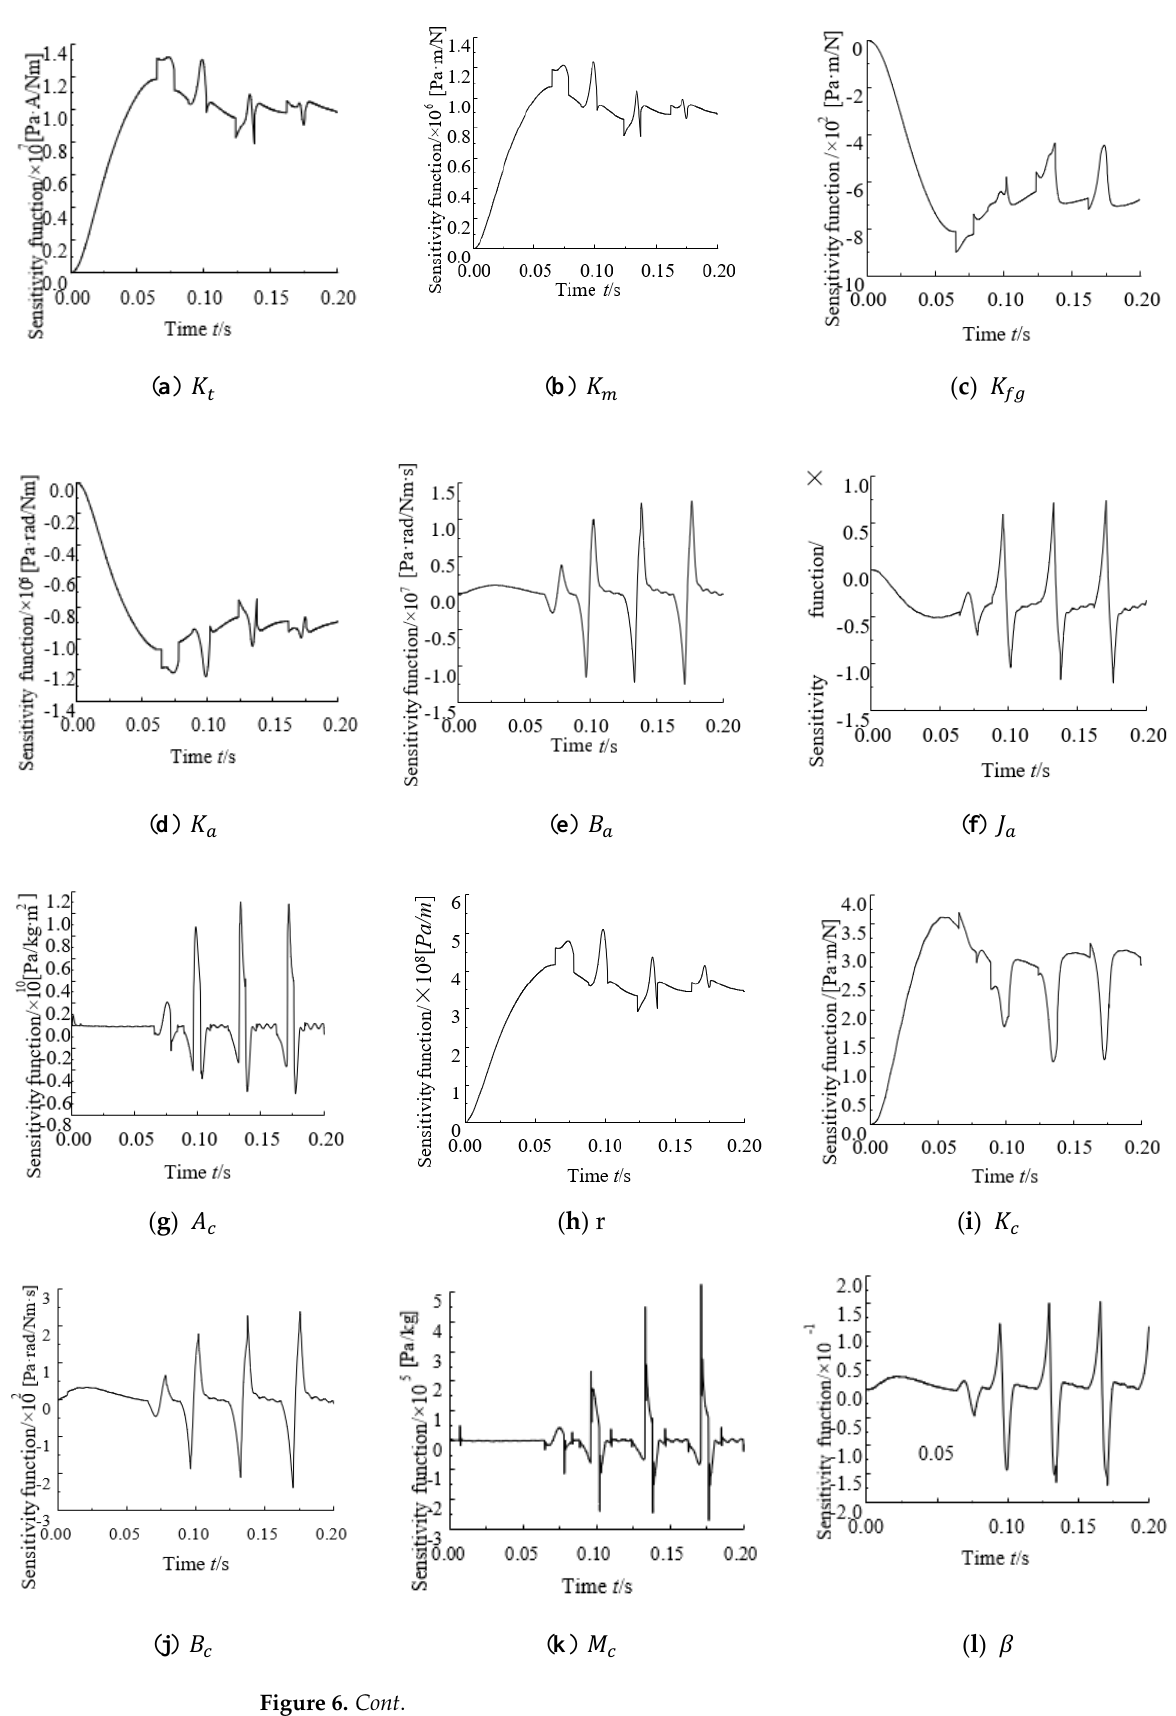
𝛽𝛽 Figure 6. Cont